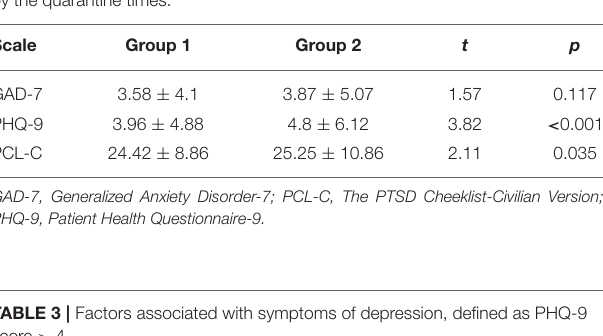
TABLE 2 | Symptoms of anxiety, depression, and PTSD in participants stratified by the quarantine times.